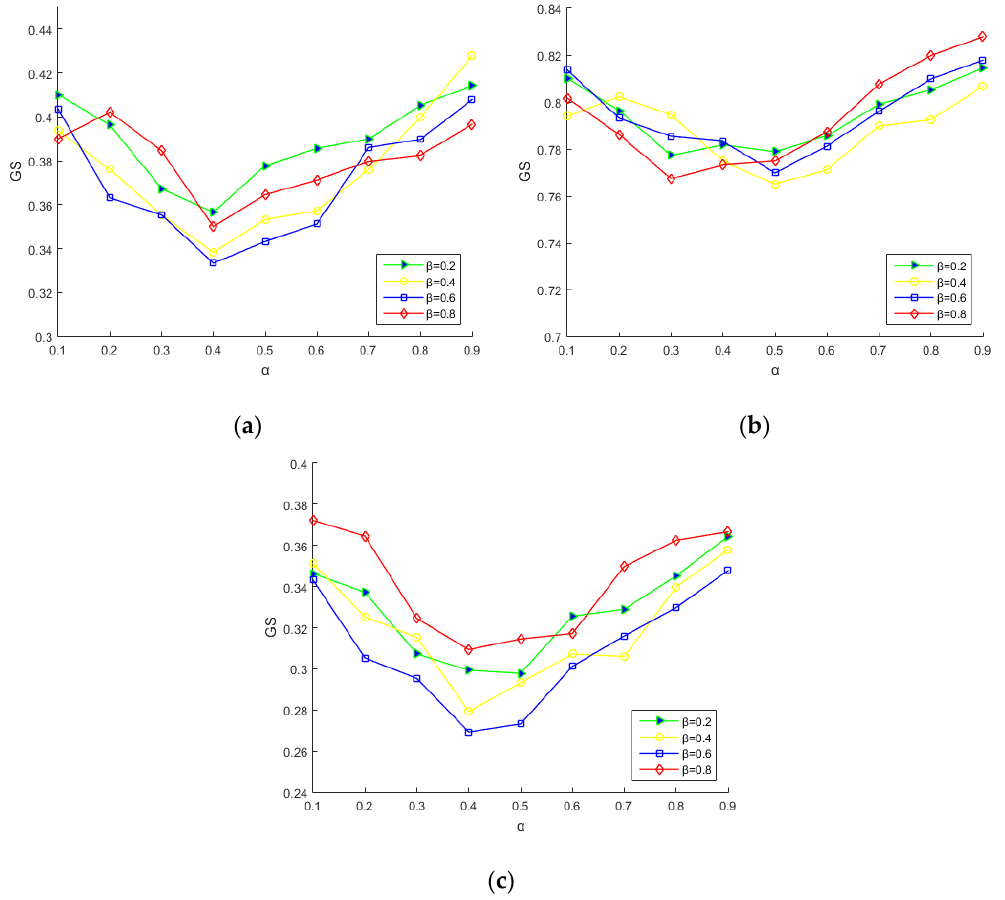
and texture of MMHS— ( 𝛼𝛼 ) ( 𝛽𝛽 )